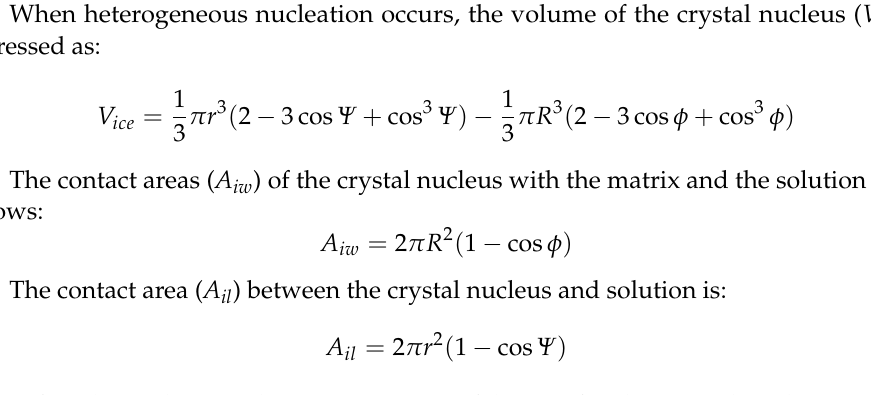
Figure 1. Schematic diagram of the heterogeneous nucleation mechanism